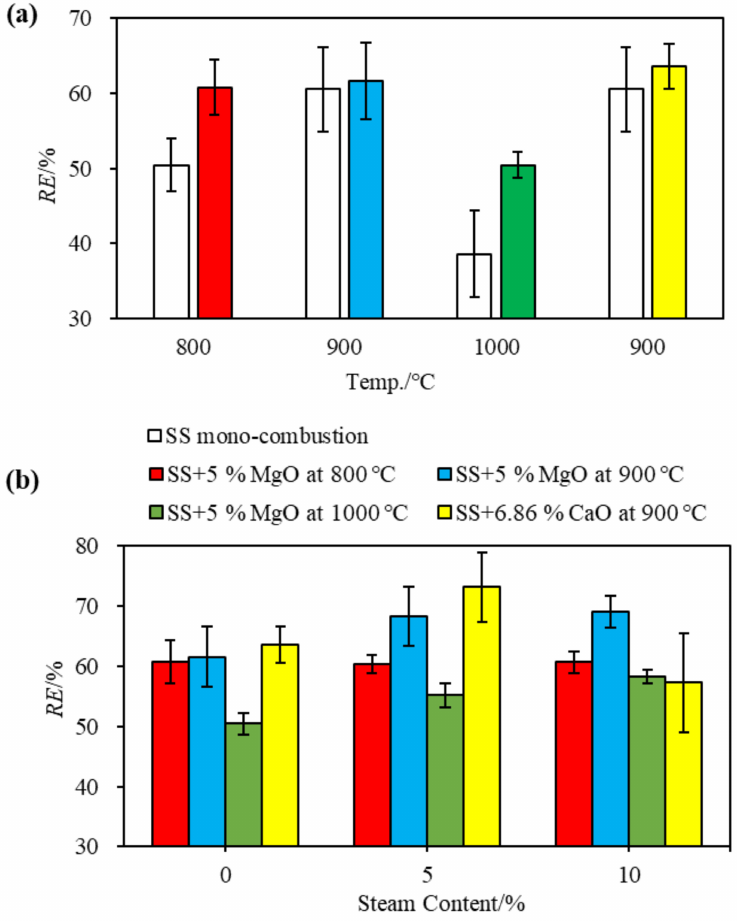
Figure 5. The RE of phosphorous in SS ash achieved by magnesian or calcic additive during SS combustion at 800–1000 ◦ C: ( a ) without extra steam; ( b ) with extra 5% or 10%